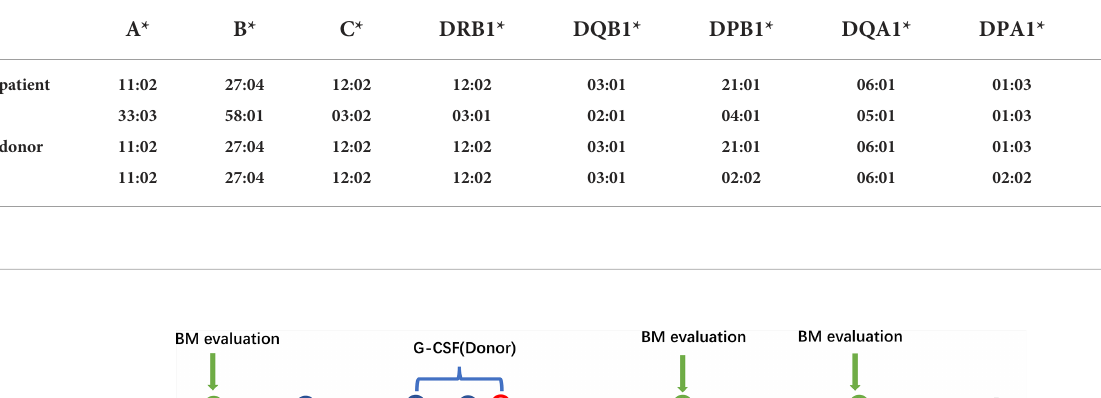
TABLE 1 The result of patient and donor HLA typing.